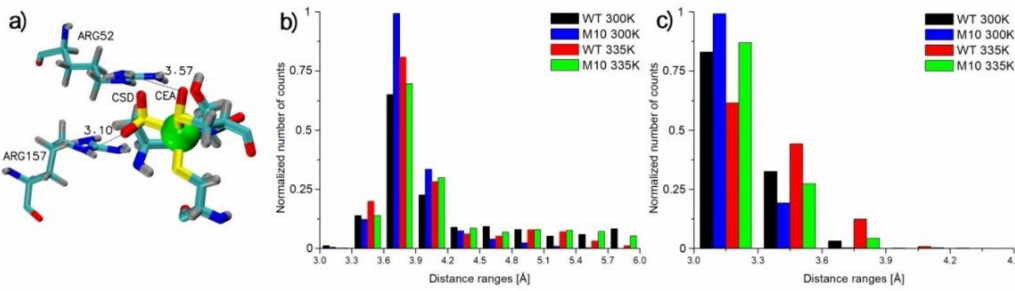
Figure 9. ( a ) Active site, β Arg52 and β Arg157 (based on crystal structure 1IRE). ( b ) Distance histogram between C ζ β Arg52 and O δ CEA113. ( c ) Distance histogram between C ζ β Arg157 and O δ 1 CSD111.